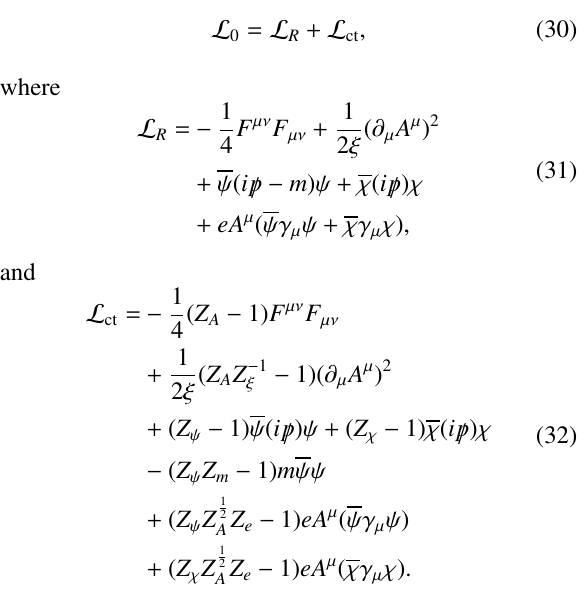
are connected to the renormalized ones